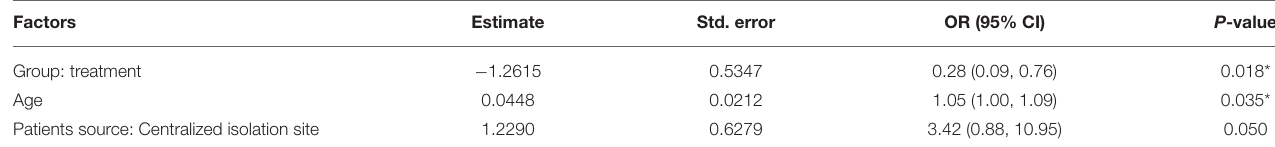
TABLE 4 | Multivariate logistic regression analysis for the rate of worsening.